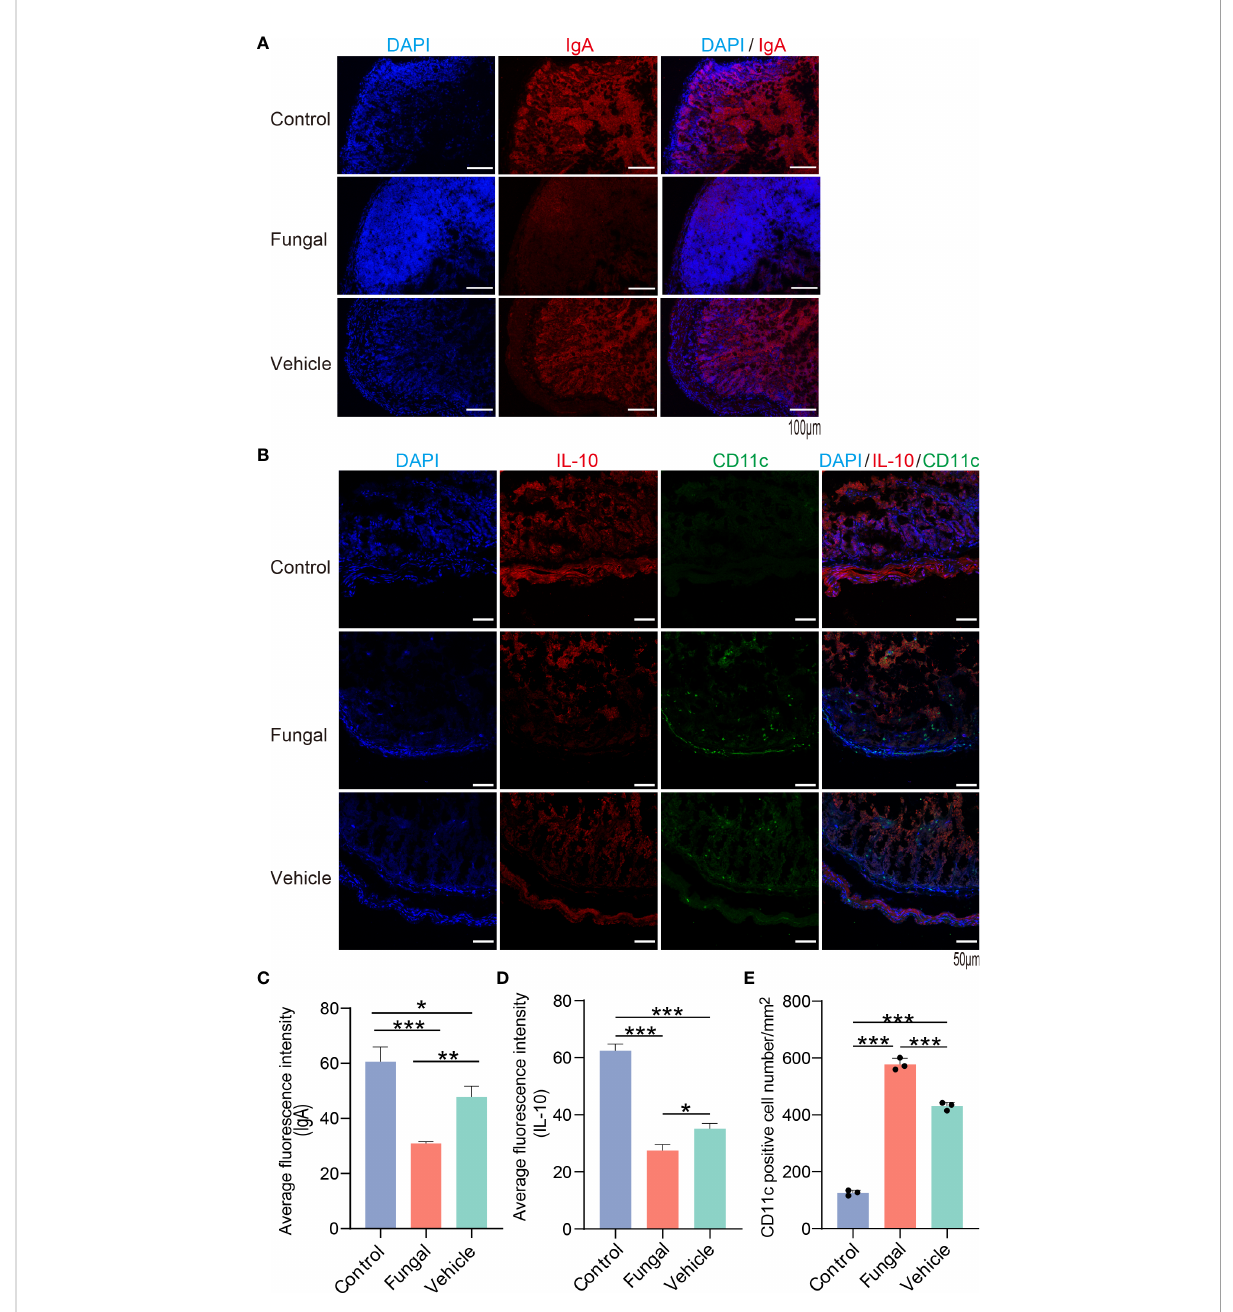
FIGURE 6 The expression of IL10 and IgA in intestinal tissues of rats with fungal infection decreased after antibiotic treatment. (A) IgA (red) and DAPI for nuclei (blue) and (B) IL10 (red), CD11c (green) and DAPI for nuclei (blue) in intestinal tissues of rats of the three group. (C, D) : The average fl uorescence intensity of IgA and IL10. (E) Number of CD11c + cells/mm 2 . *P < 0.05, **P < 0.01, ***P < 0.001, by one-way ANOVA with Tukey ’ s multiple comparisons test. Data are presented as the mean ± SD of at least 3 independent